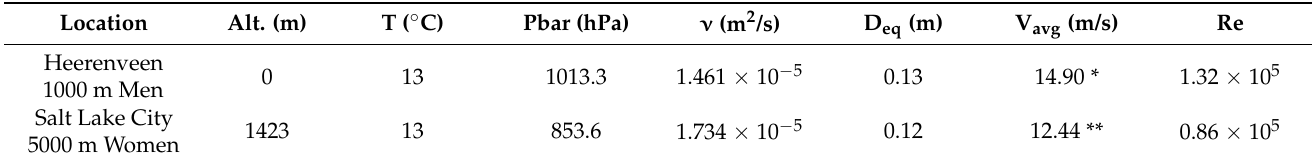
Table 7. Extremities in lower-leg Reynolds number, following from track records for male and female skaters. Location Alt.